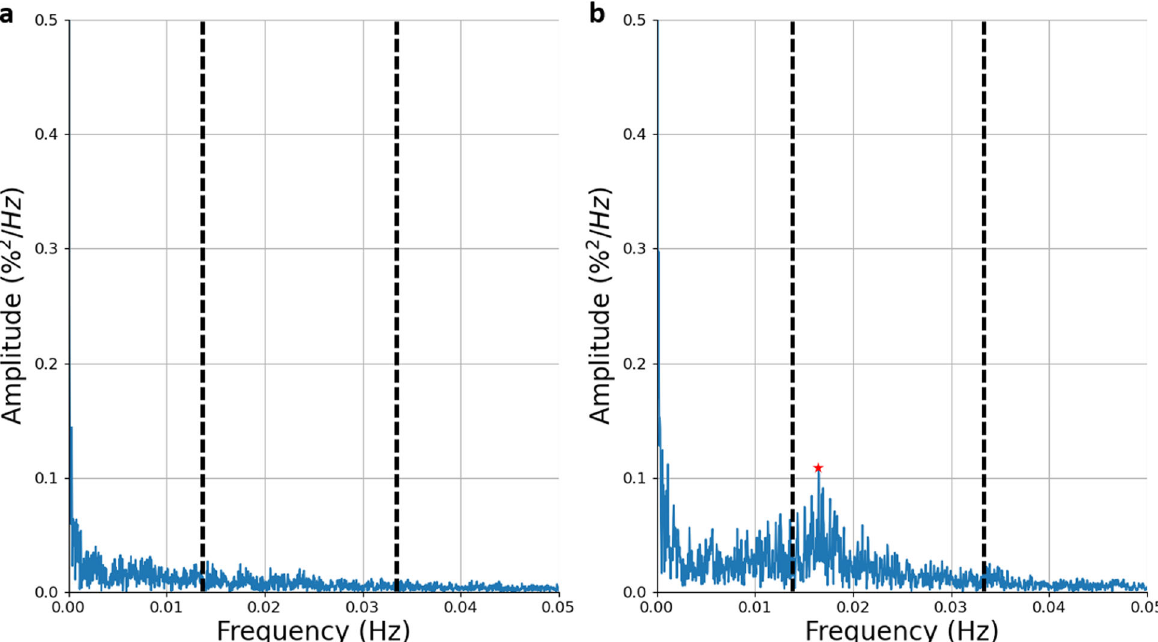
Fig. 6 Power spectral density (PSD) of the oximetry time series. Example on a a non-OSA individual and b a patient with moderate OSA. The band 0.014 – 0.033 Hz is delineated by the vertical dashed lines. In b , the peak within this band is located at f = 0.017 Hz, as highlighted by the red star.